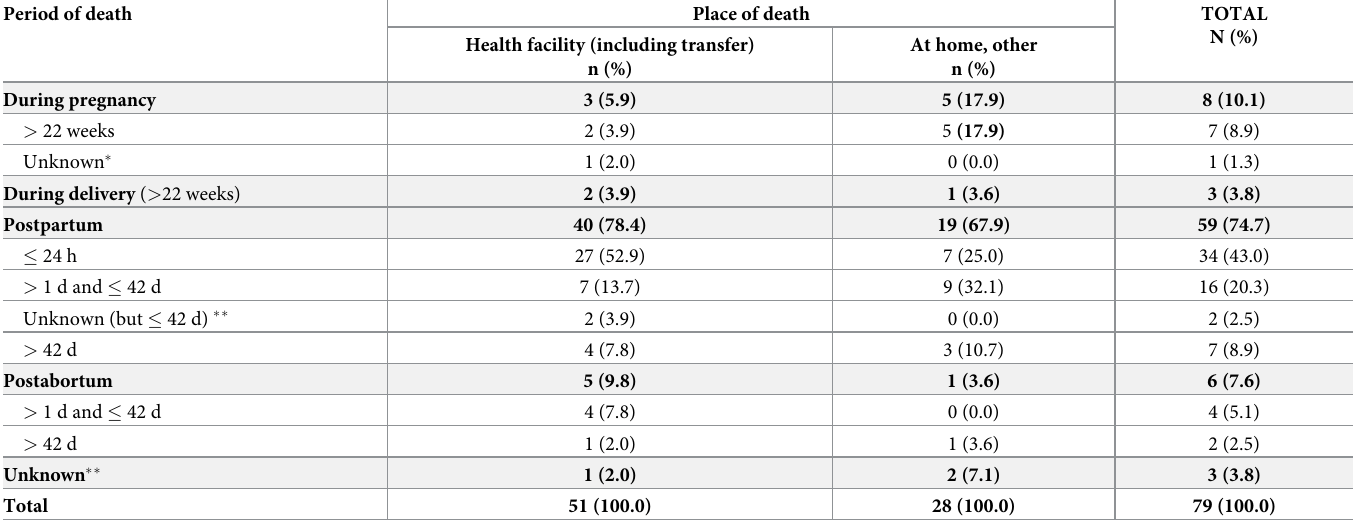
Table 2. Time and place of deaths (N =